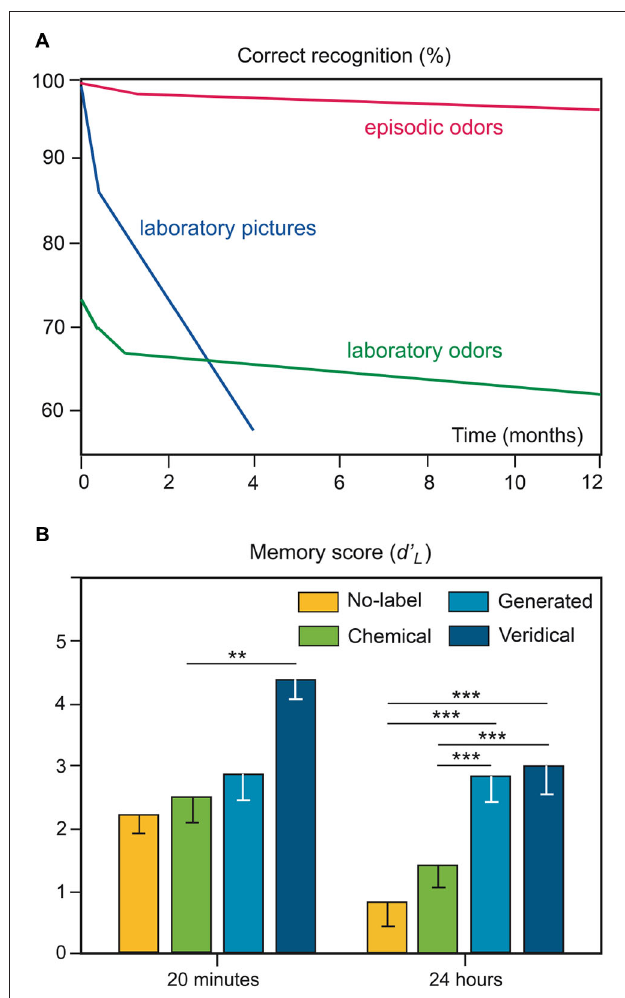
FIGURE 2 | Odor recognition memory. (A) Ability to recognize laboratory pictures and odors over a span of 1 year. The hypothetical curve of the ability to recognize episodic odors (odors associated with significant real-life experiences) is shown for comparison (adapted from Engen, 1987). (B) Impact of semantic processing on odor recognition memory performances. Memory scores for odors that were previously associated with no labels, chemical labels, labels generated by the participants or veridical labels. ** p < 0.01; *** p < 0.001 (adapted from Jehl et al.,